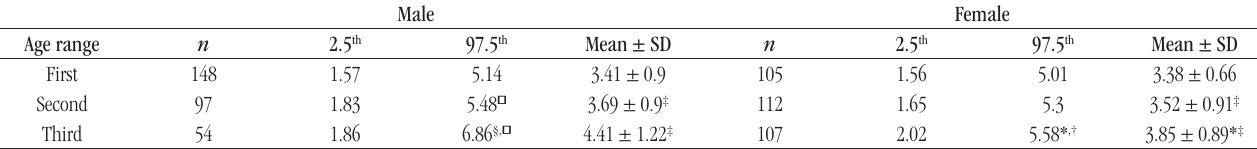
taBLE 2 − Limits for the reference interval at the 95 th percentile and mean UrA concentrations (mg/dl) in eutrophic children and adolescents by sex and age range